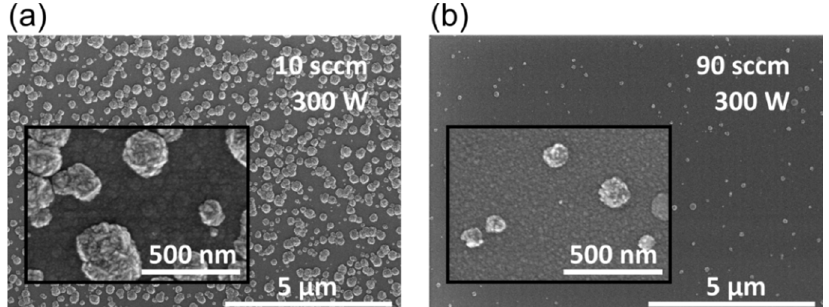
Figure 1. SEM images of the surface of TiO 2 layers deposited on Si substrate under the following process conditions: 300 W plasma power; 100 °C substrate temperature; 10 sccm ( a ), and 90 sccm ( b ) oxygen gas flow corresponding to 5.7 Pa and 22.6 Pa chamber pressure, respectively.